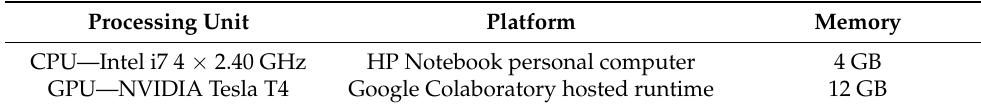
Table 5. Hardware platforms specifications for DL